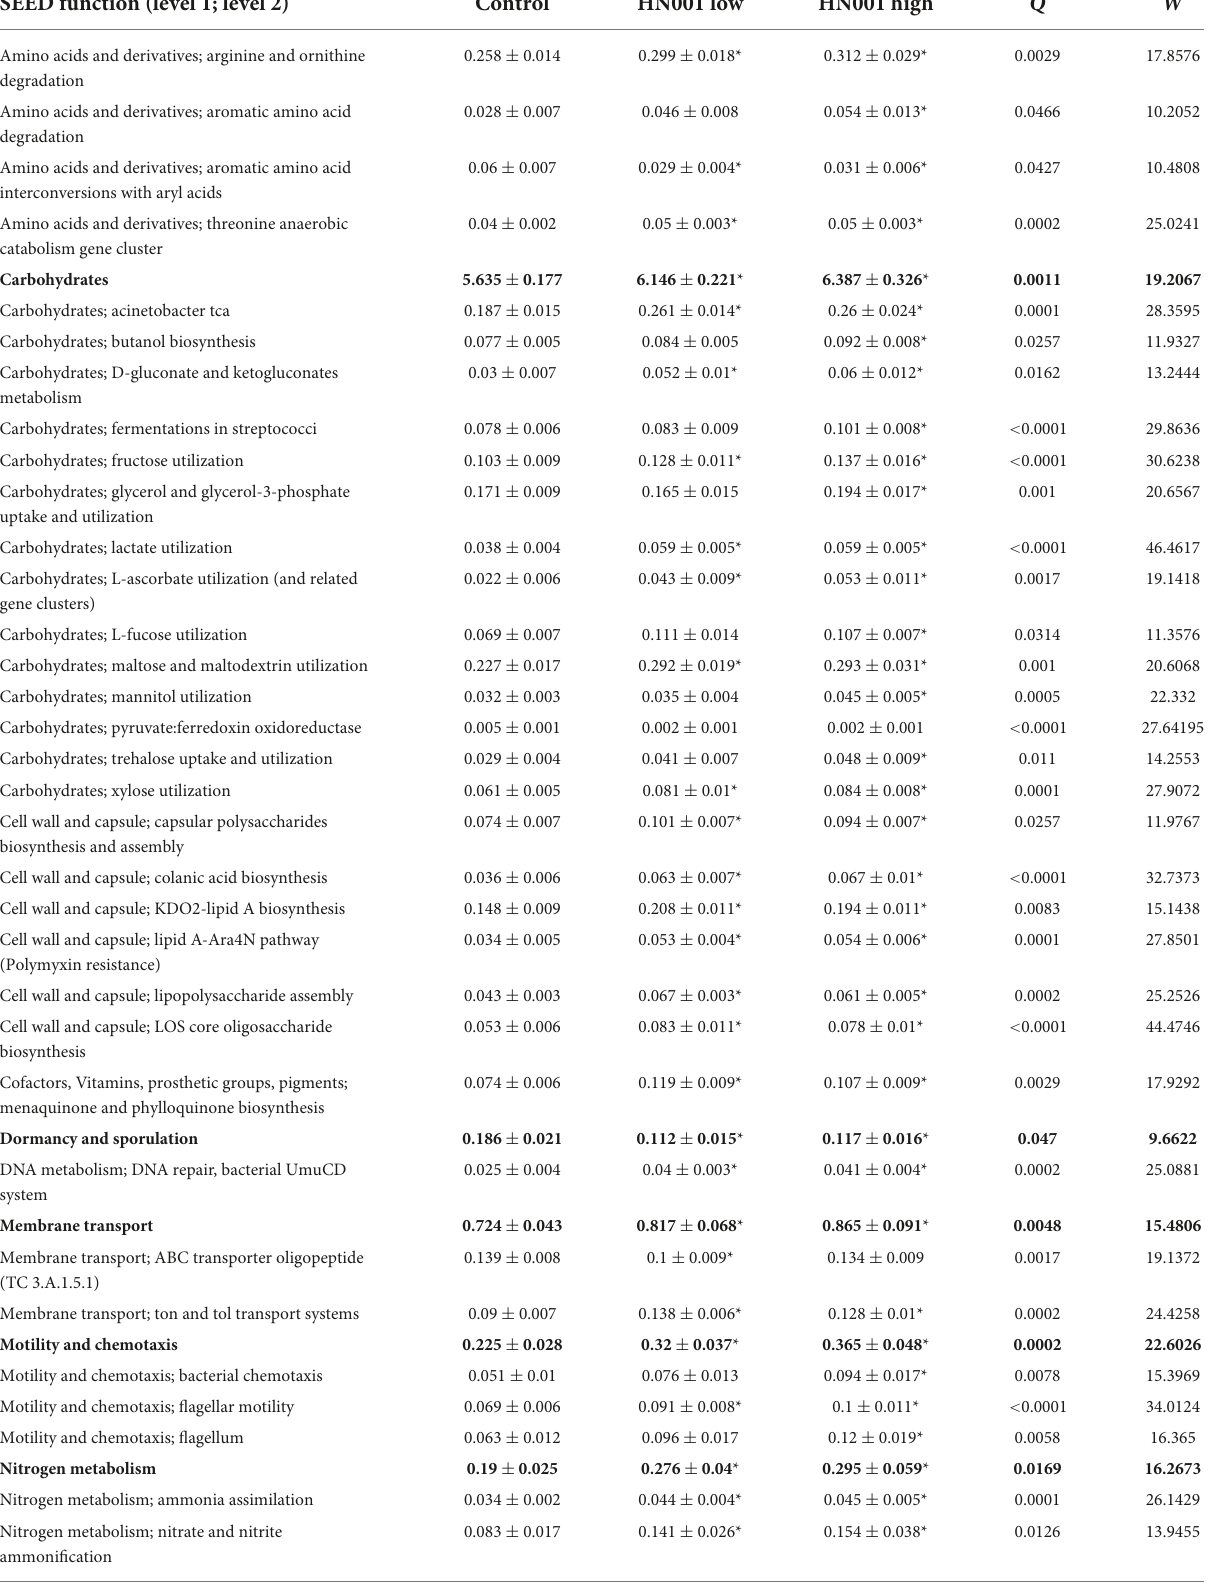
TABLE 2 SEED level 1 functions and top 50 most abundant microbial SEED level 2 functions with significantly different (global ANCOM-BC Q < 0.05) mean relative abundances in the cecum of piglets fed infant formula supplemented with L. rhamnosus HN001 and control formula. SEED function (level 1; level